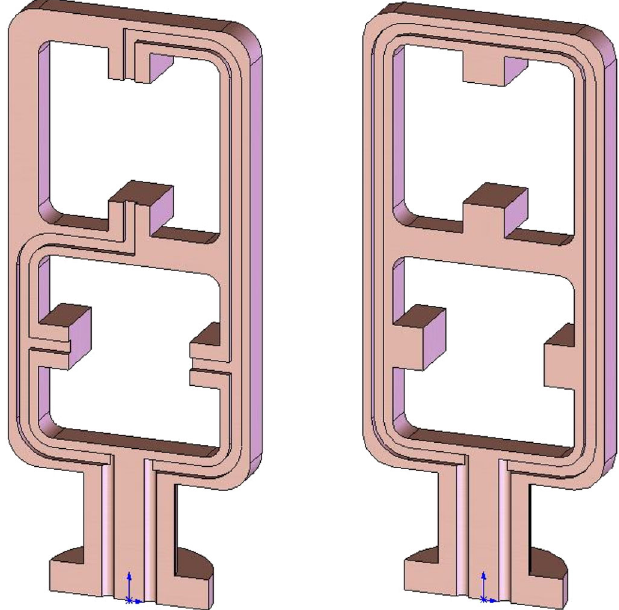
FIG. 8. Cross-section images of the stems.